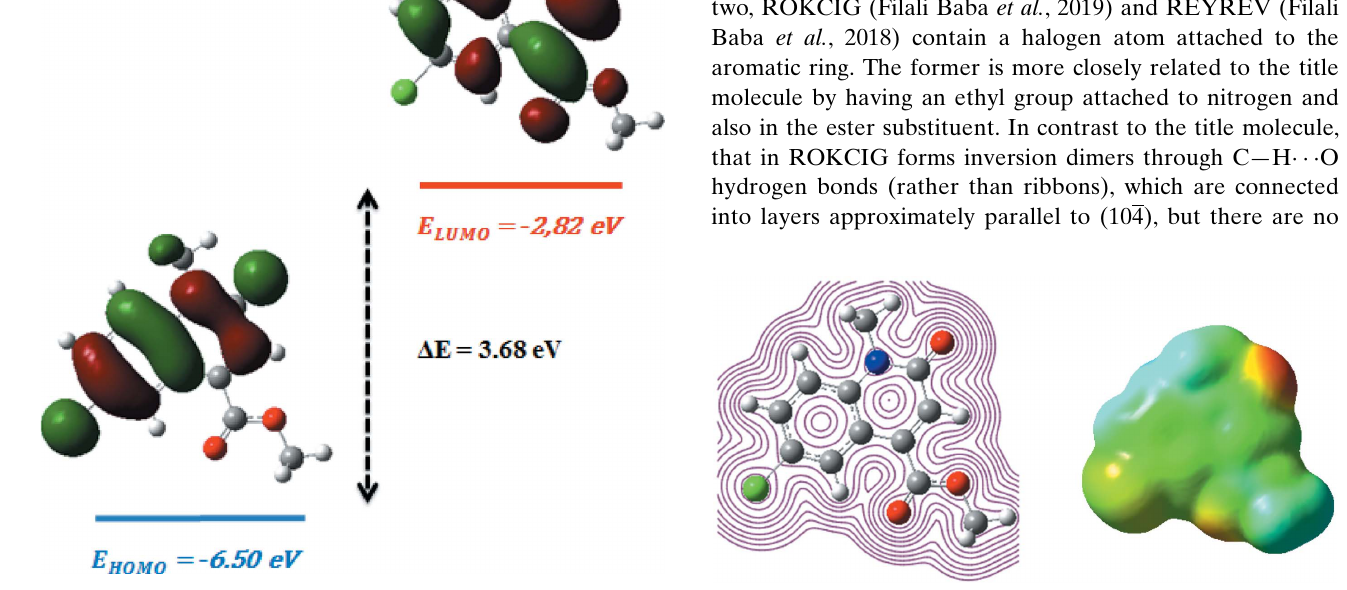
Figure 8 The energy band gap of (I).